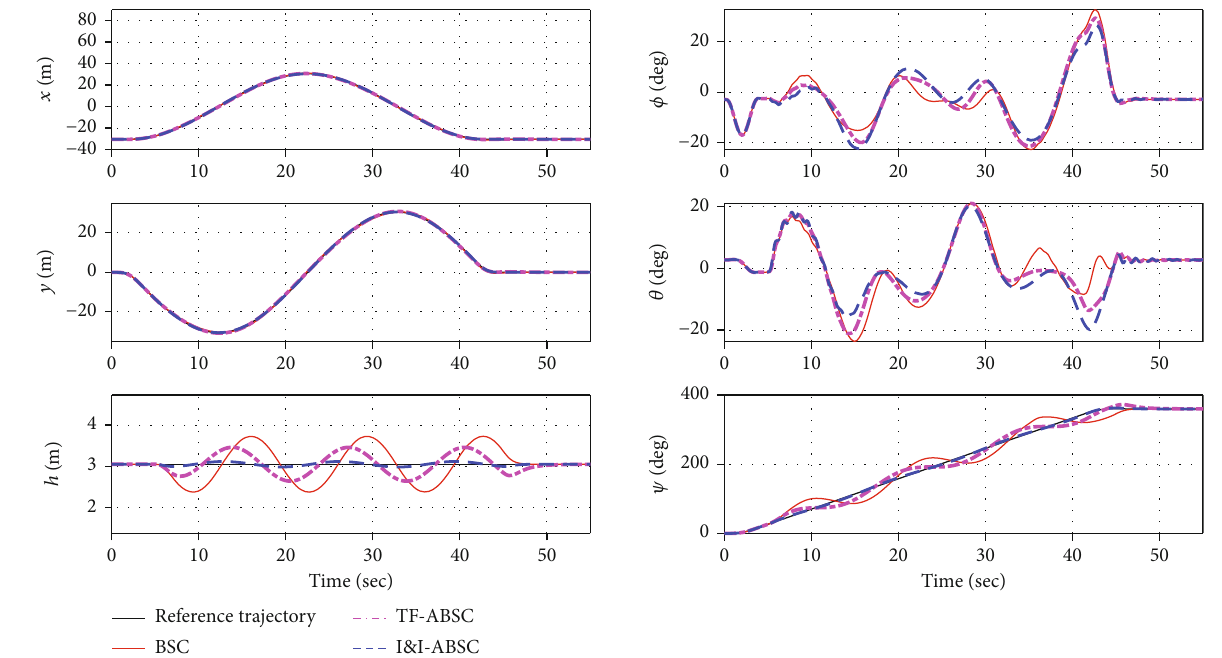
Figure 4: Case A: position tracking results of BSC, TF-ABSC, and